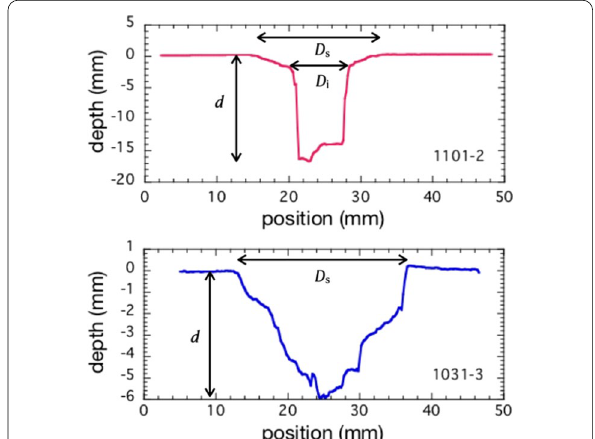
Fig. 2 Typical crater profiles resulting from impact of a closed copper tube on (upper) porous gypsum target (shot # 1101-2) and (lower) basalt target (shot # 1031-3). The surface diameter, D s , the inner (pit) diameter, D i , and the depth, d , are defined as the diameter at the target surface, the diameter at the pit, and the distance from the surface to the deepest part of the crater, respectively. Note that the vertical scale is